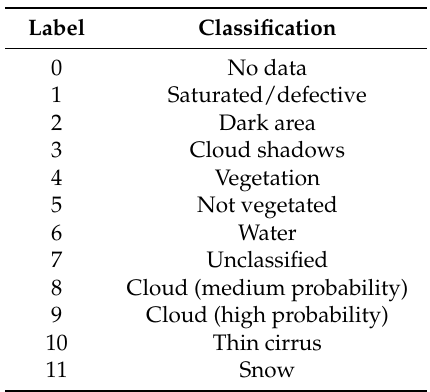
Table 6. Classes of Sen2Cor SCL